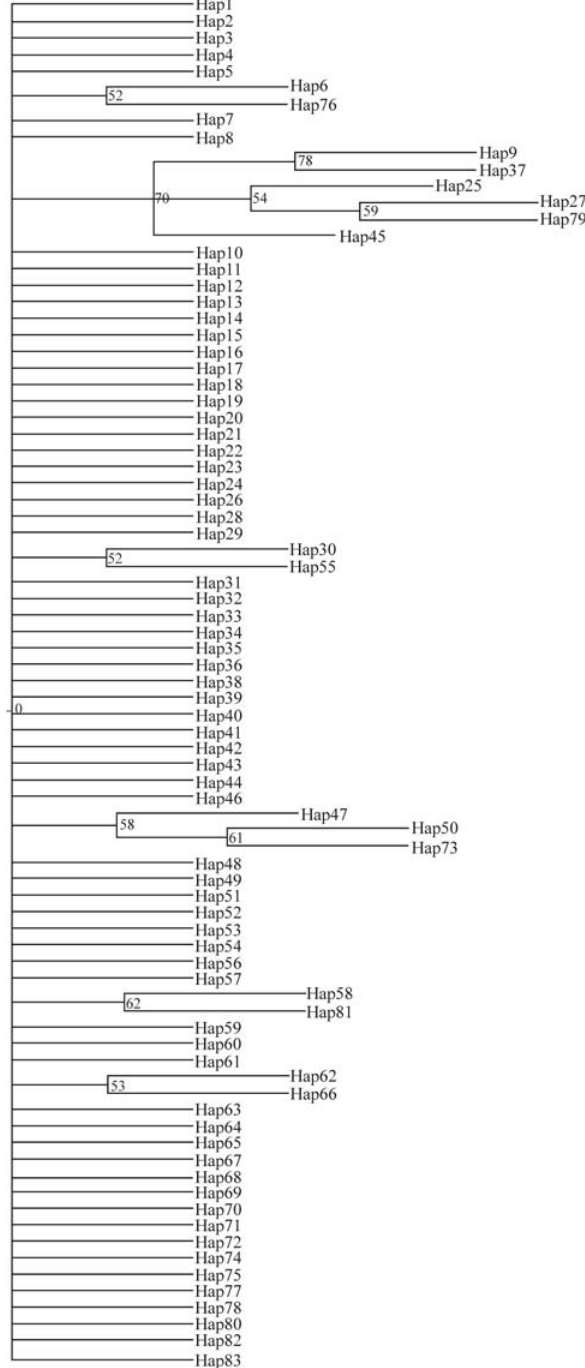
Figure 1 - Neighbor-joining tree of mitochondrial D-loop haplotypes in Cynoscnion acoupa from the northern coast of Brazil. Numbers at nodes indicate the percentage bootstrap support from 1,000 replicates (values of less than 50% are not shown).